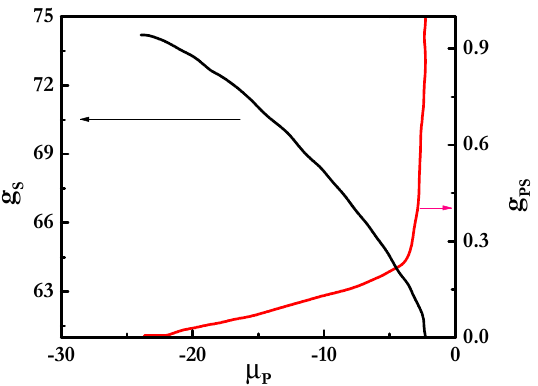
Figure 6. Dependences of the aggregation number of surfactants in the complexes ( g s , left axis) and the degree of polyelectrolyte–surfactant binding ( g PS , right axis) on μ P for mixtures of PDADMAC with APG.